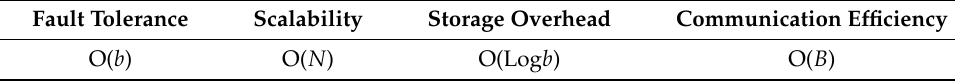
Table 1. System performance